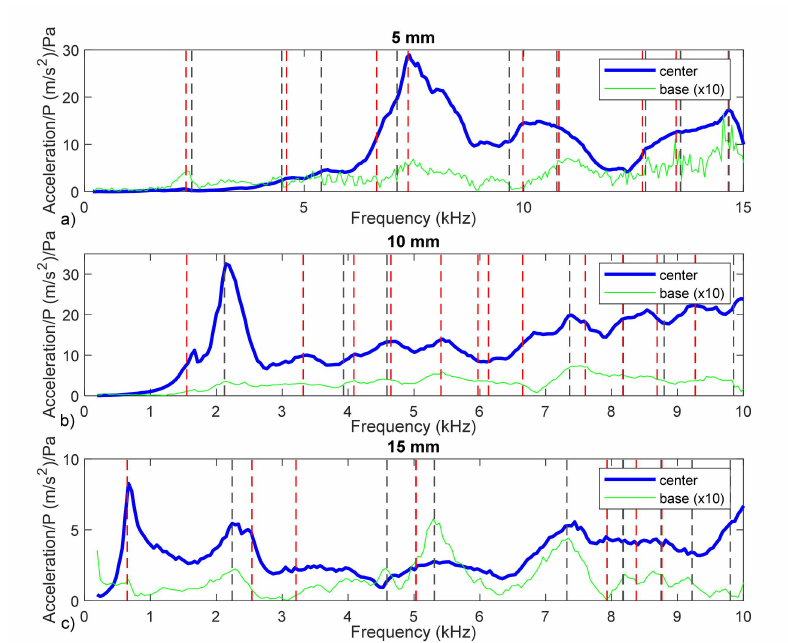
Figure 12. Membrane acceleration transfer function. Responses of membranes with diameters of 5 mm ( a ), 10 mm ( b ), and 15 mm ( c ) for the center location (blue curve) and edge location (green curve). Resonant frequencies added at the center (red line) and at the border (grey